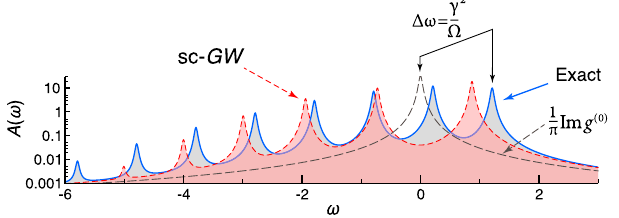
Figure 2. Spectral function at the following values of the parameters  = 0, Ω = 1, γ = 1.1, η = 0.03 and different levels of theory: exact (full line), self-consistent first-order (short dashes), zeroth iteration (long dashes). Shaded areas are equal to unity.